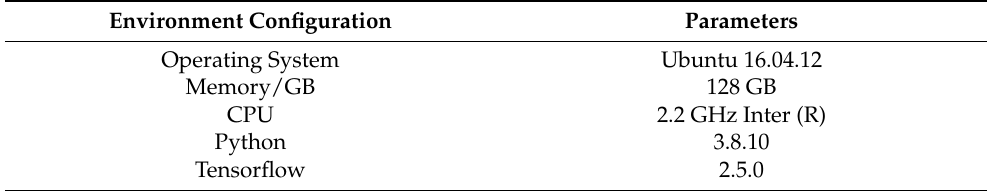
Table 1. Experimental environment